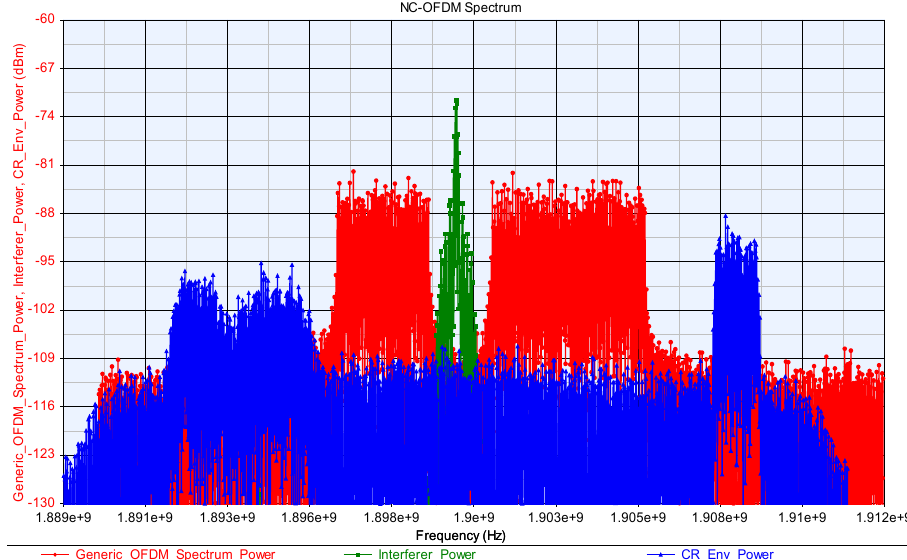
Figure 4. Spectrum of NC-OFDM